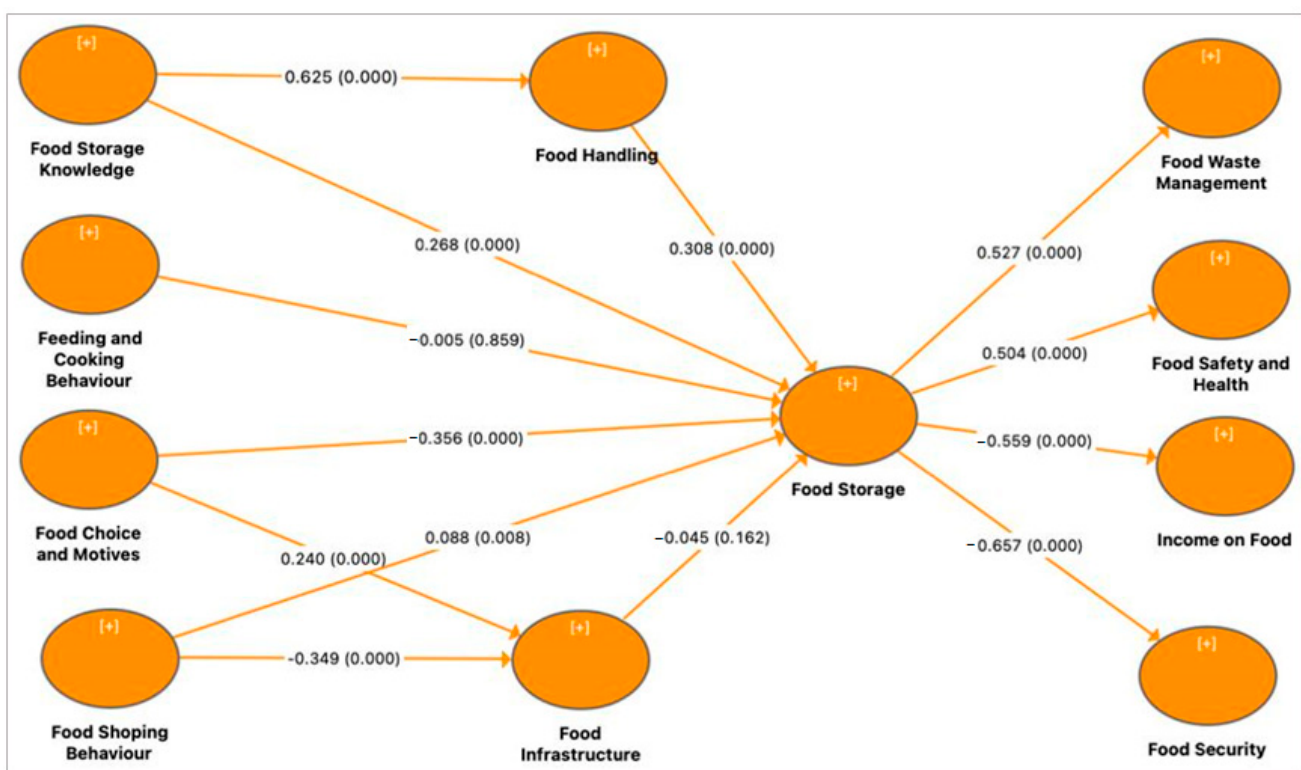
Figure 3. Network analysis of determinants of household-level food storage practices and outcomes on food safety and security. The +/- indicates the strength of the relationship between and among the clustering variables. The [+] indicates positive relationship between clustering variables at p ≤ 0.05 level of significance.